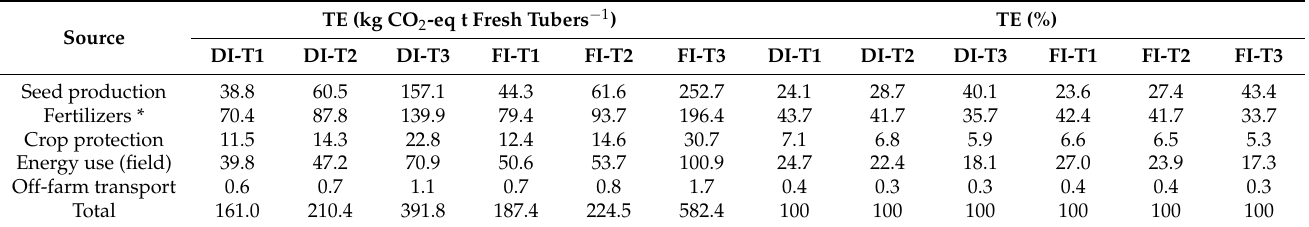
Table 2. Average total carbon emissions (TE, kg CO 2 eq. to fresh tubers − 1 ) are divided into different agricultural activities under drip irrigation (DI) and furrow irrigation (FI) using timing schedule irrigation treatments: control (T1), 0.4 (T2), and 0.7 (T3) thresholds of crop water stress index (CWSI). Calculations were made using the Cool Farm Tool [30].